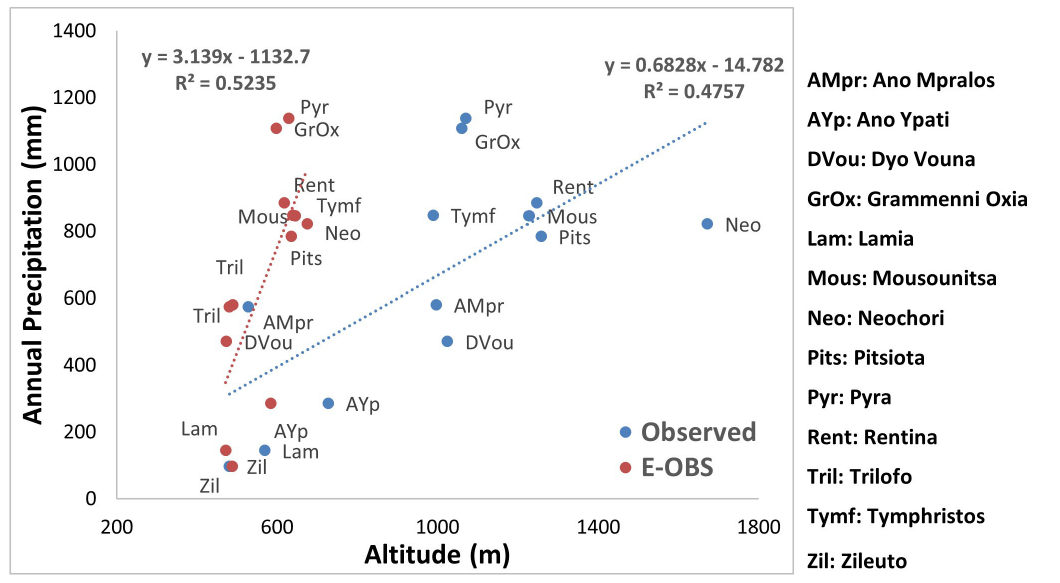
Figure 6. Precipitation lapse rates of Spercheios river basin based on observational meteorological data and E-OBS